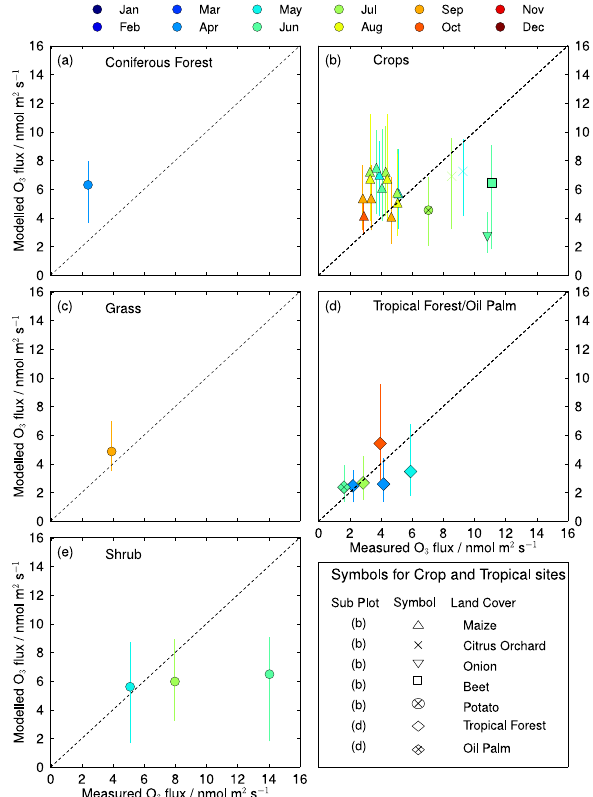
Figure 11. Measured and modelled monthly average O 3 dry depo- sition fluxes at short term measurement sites. Colours indicate the average flux for the relevant month and shapes indicate the mea- surement